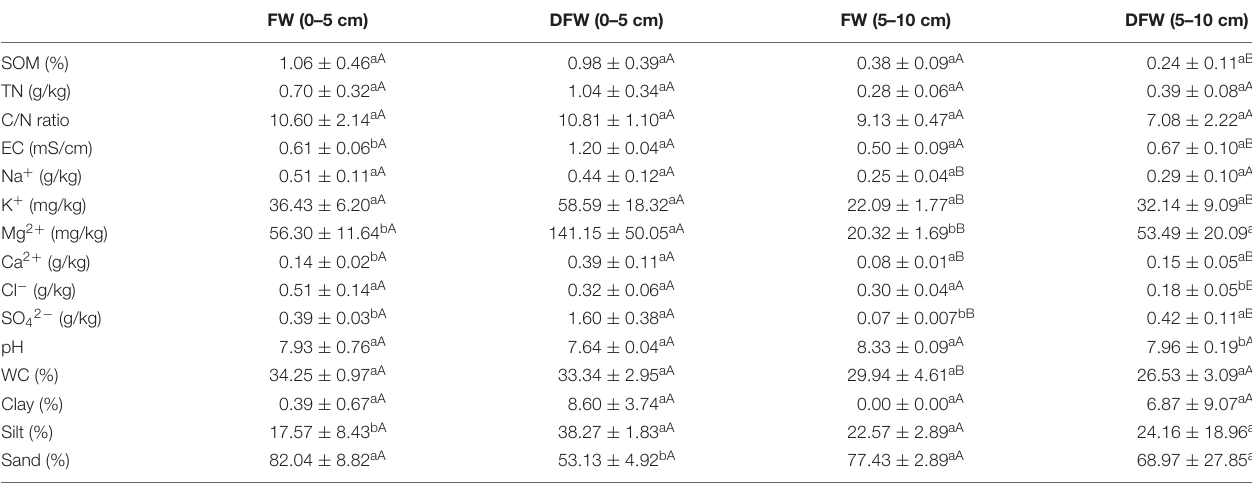
TABLE 1 | The changes of soil properties before and after